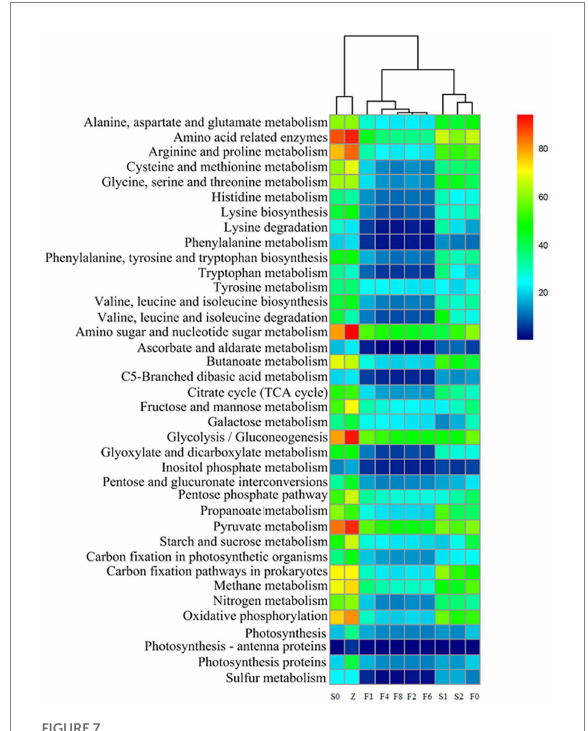
FIGURE 7 Functional prediction of amino acids, carbohydrates and energy metabolism of the